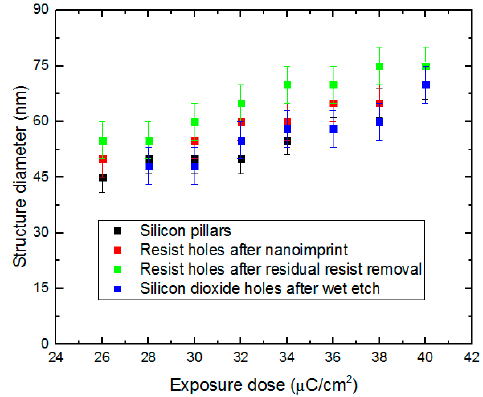
Figure 7. Nanostructure diameters after different fabrication steps.